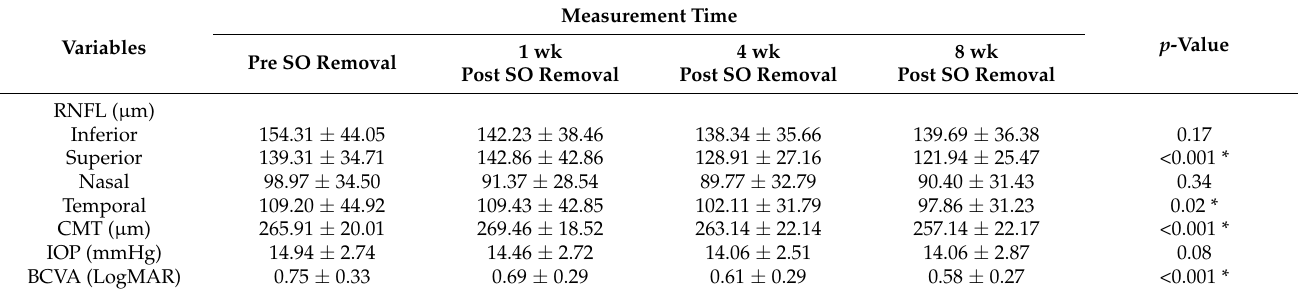
Table 1. The mean differences in best corrected visual acuity, intraocular pressure, central macular thickness, and retinal nerve fiber layer thickness between pre- and post-silicone-oil removal. Measurement Time p -Value 1 wk 4 wk 8 wk Pre SO Removal Post SO Removal Post SO Removal Post SO